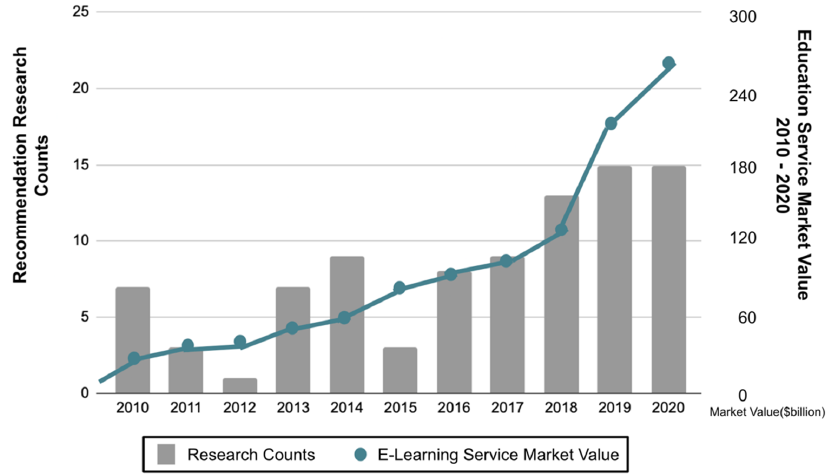
Figure 29. Education service field research trends and e-learning service market value from 2010 to 2020.